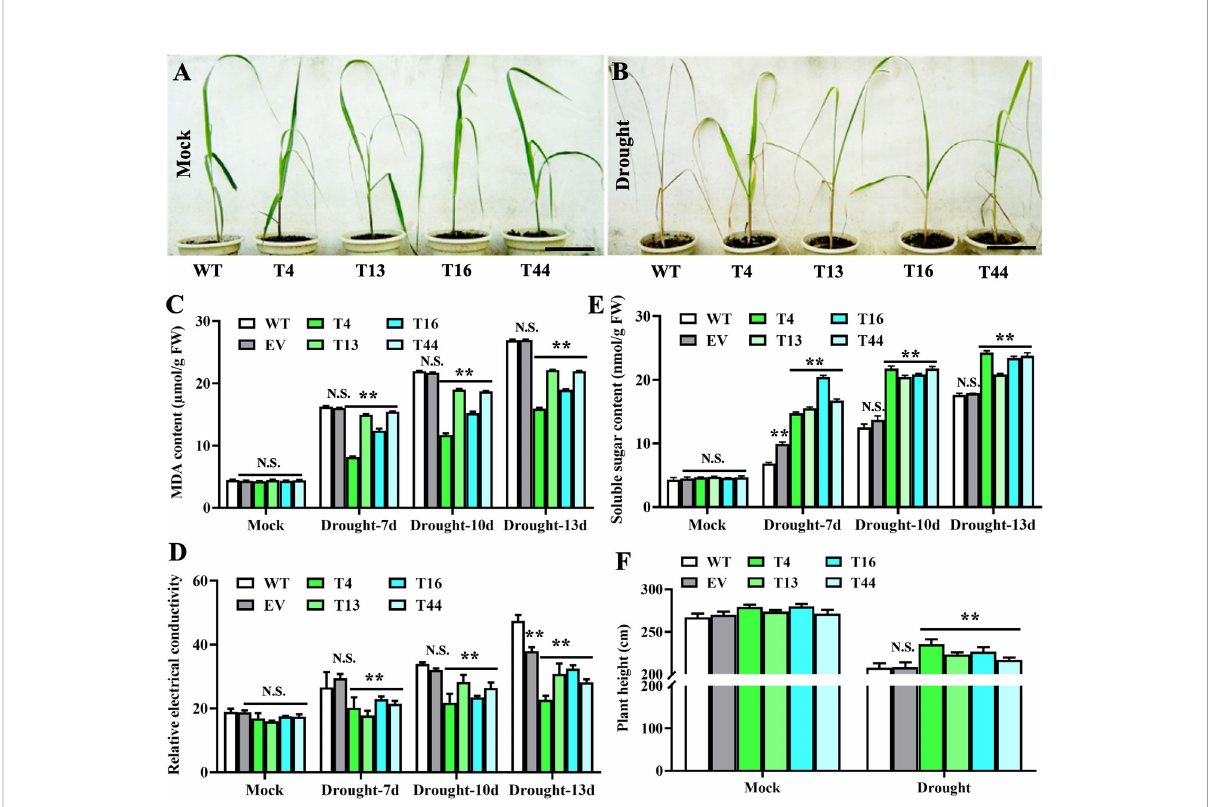
FIGURE 3 Prd29A: TaDREB2B sugarcane positively regulates the drought tolerance without compromising growth in the greenhouse . (A, B) Performance of wild type (WT) and Prd29A: TaDREB2B transgenic sugarcane seedlings under well-watered (A) and severe drought (B) conditions. (C – F) The determination of malondialdehyde content (C) , relative electrical conductivity (D) , soluble sugar content (E) , and plant height (F) in WT, empty vector (EV), and Prd29A: TaDREB2B transgenic sugarcane seedlings after drought treatment. EV represents the transgenic sugarcane transformed with an empty vector. The values are the means ± SD; n=6. All statistical analyses were performed using Student ’ s t -test: NS, no signi fi cance; ** P <